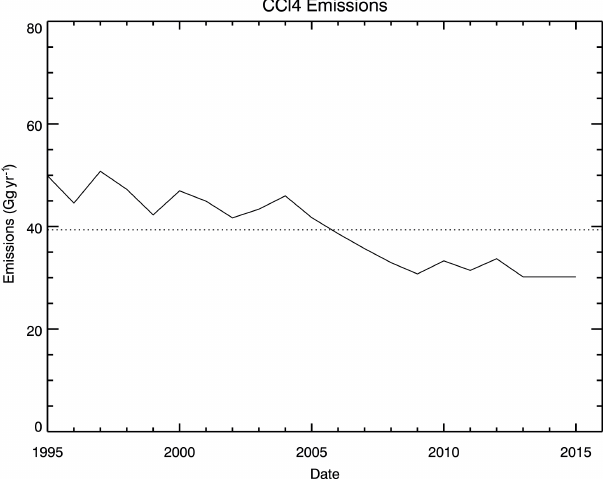
Figure 1. Time variation of global annual emissions (Ggyear − 1 ) derived from measured global atmospheric changes and a global box model (solid line). The emission record was used for the stan- dard TOMCAT model experiments. The mean emissions over the period 1996–2015 are 39.35Ggyear − 1 (indicated by dotted